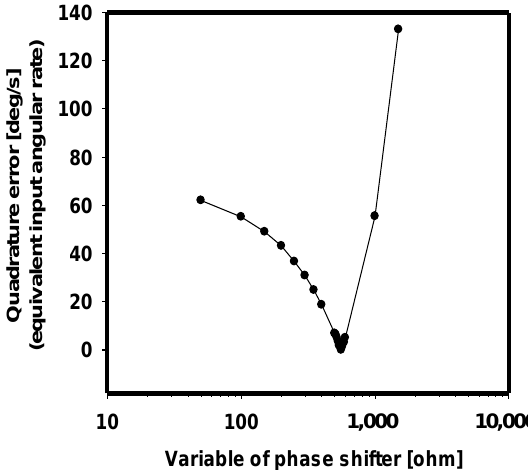
Figure 9. Quadrature error as a function of the resistance of the phase shifter in response to 100°/s. The graph indicates a quadrature error of 0.00323°/s at the significant optimal point, 560 Ω.